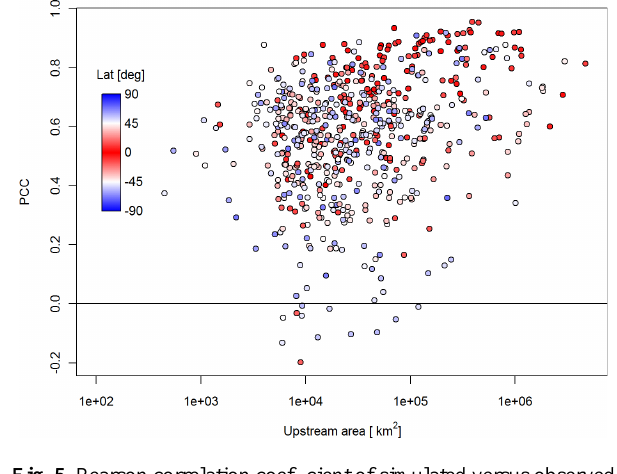
Fig. 5. Pearson correlation coefficient of simulated versus observed discharge for the 620 stations considered plotted against the cor- responding upstream area. Circle color depends on the latitude of each river